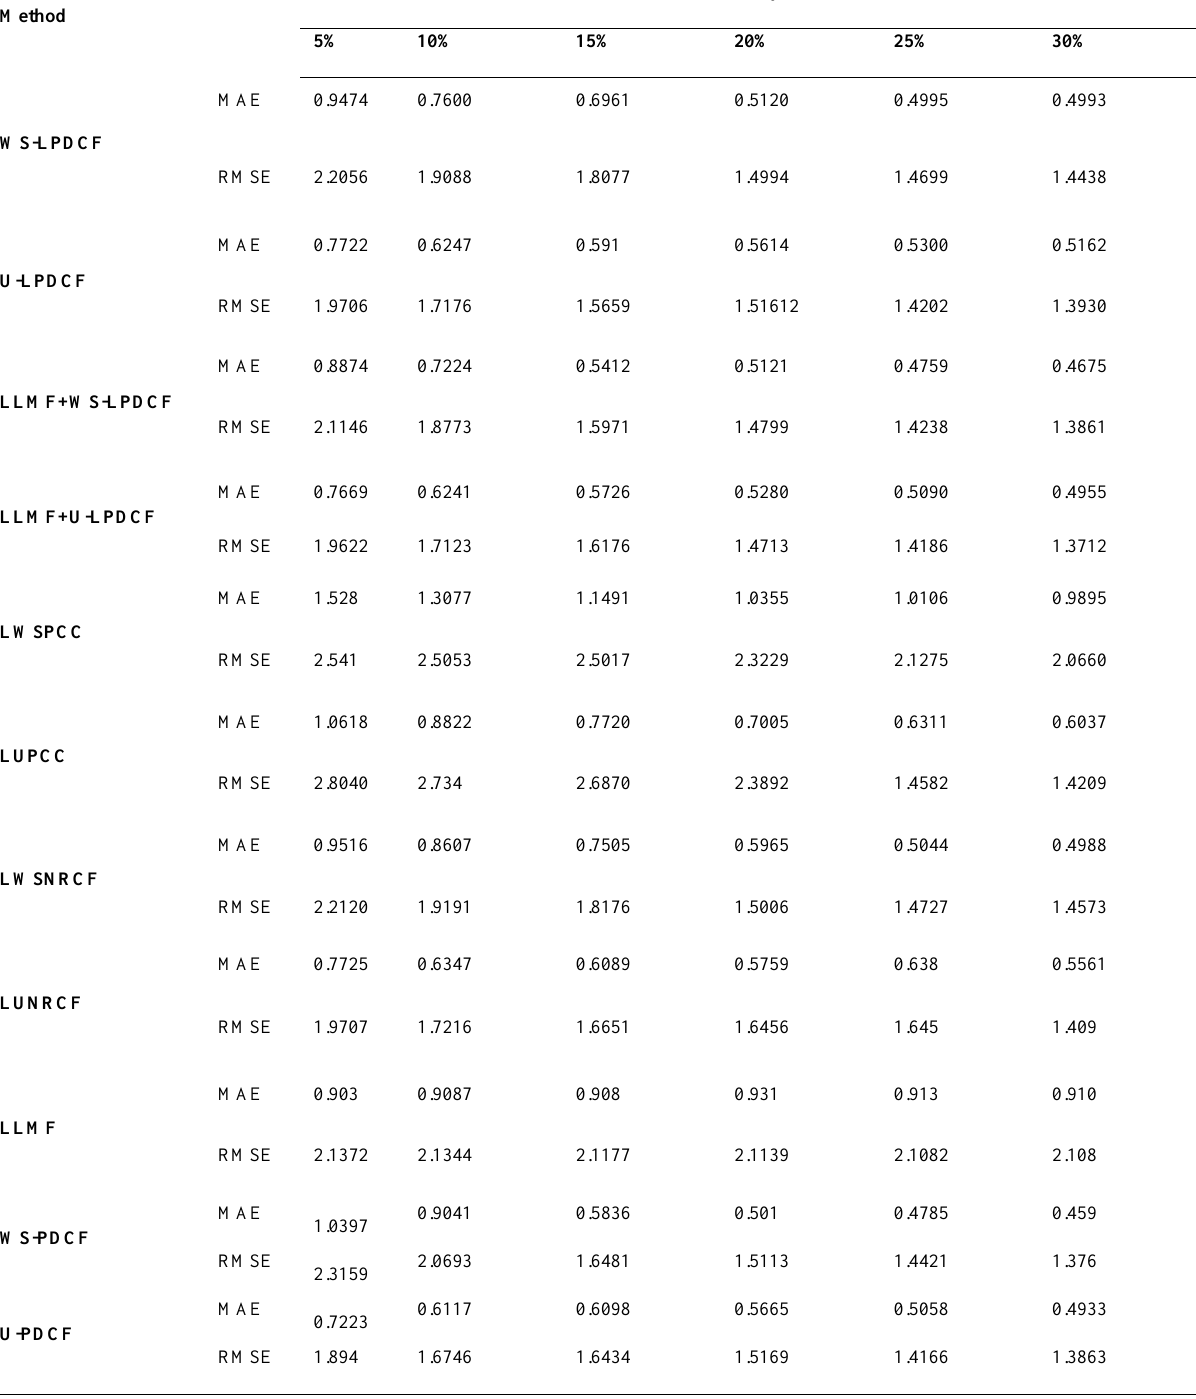
Table I. MAE and RMSE comparison between the proposed PDCF and competing methods based on different densities.